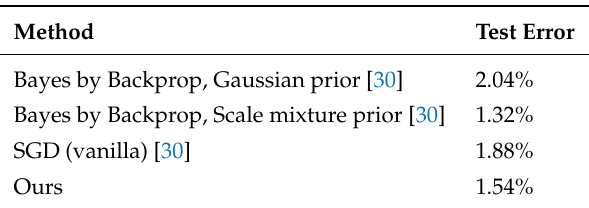
Table 6. Summary of test errors.